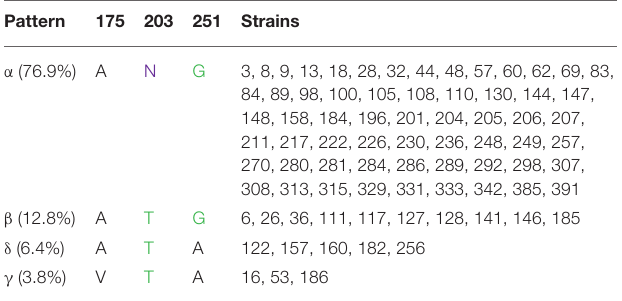
TABLE 3 | (B) Linker/dimerization domain polymorphism patterns.